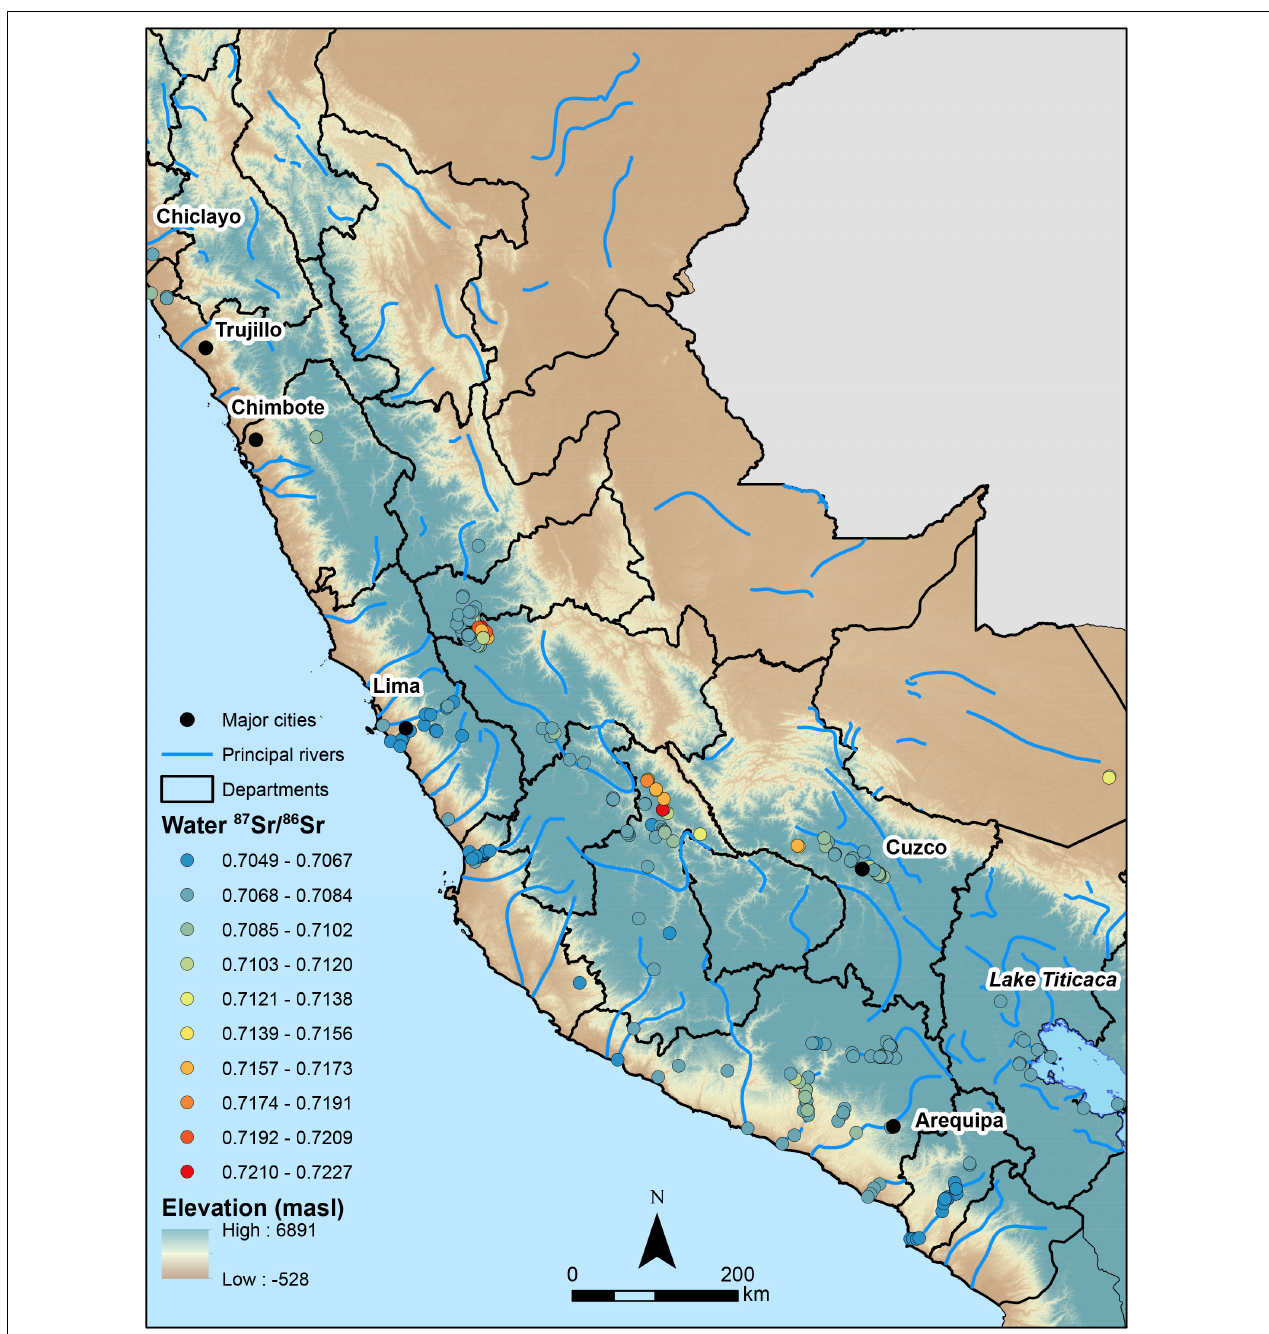
FIGURE 3 | Peruvian water 87 Sr/ 86 Sr results, arbitrarily divided into 10 equally sized bins, relative to the locations of major cities, rivers, and elevation at sampling locations ( n = 262).